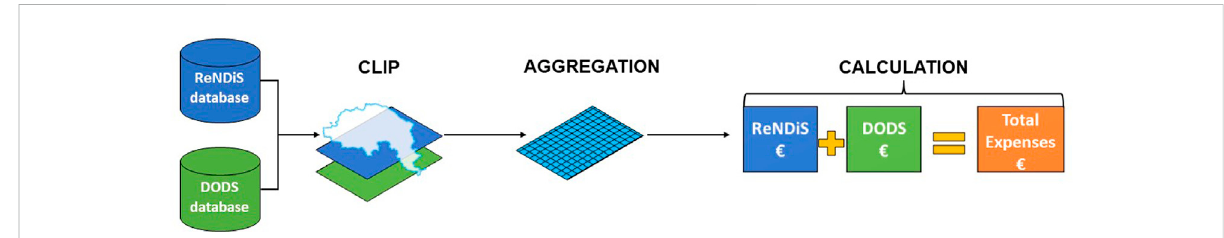
Location of the Arno River